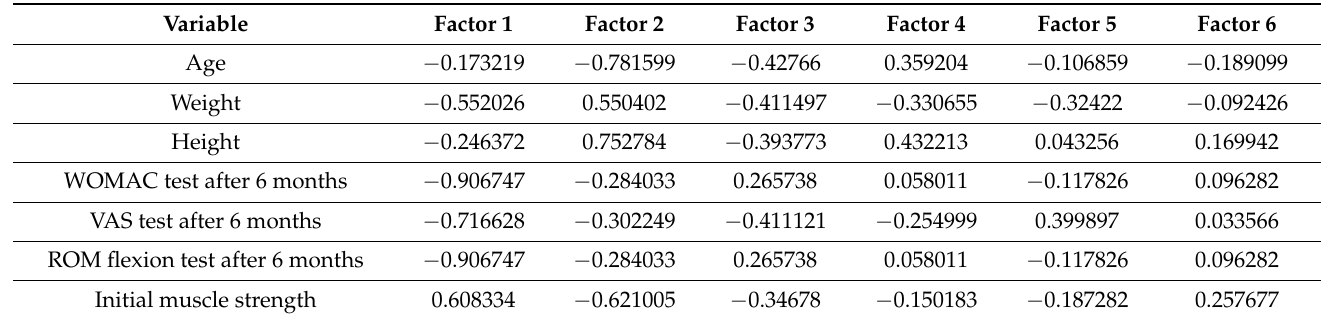
Table 13. Factor coordinates of the variables based on correlations for the control group (CG) after 6 months.